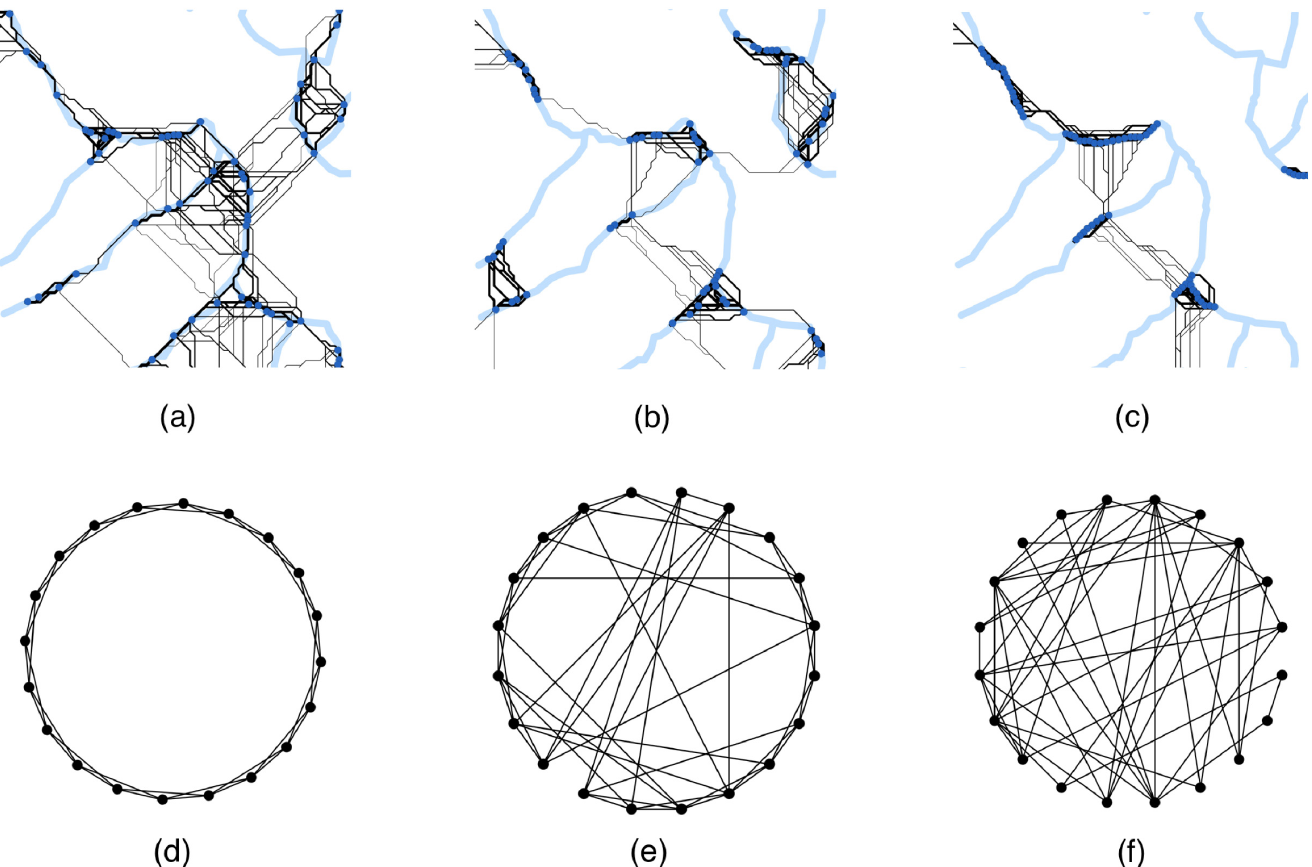
Fig 4. Networks examined. (a)–(c): Landscape-based networks. Dark-blue dots indicate nodes (habitat patches), black lines indicate links (dispersal pathways). The light-blue lines indicate the underlying stream network structure. (a) random allocation of habitat patches, (b) clustered allocation, (c) linear allocation. (d)-(f): Standard networks. (d) regular network, (e) small-world network, (f) random